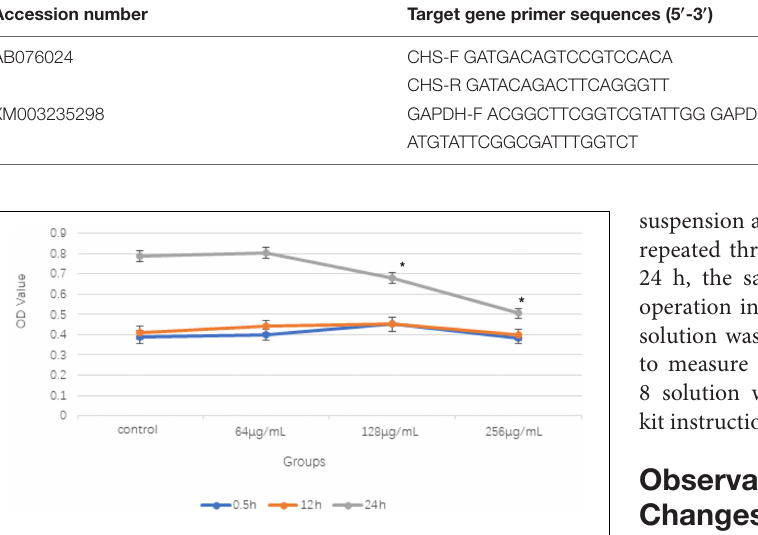
FIGURE 1 | Comparison of OD values of different concentrations of aqueous extract from Cnidium monnieri (L.) on Trichoderma rubrum in different time periods (x ± s) (* P < 0.05). 128 and 256 µ g/mL concentrations of aqueous extract from C. monnieri (L.) were used to inhibit T. rubrum for 24 h, the OD value difference was statistically significant compared with the control group (* P <